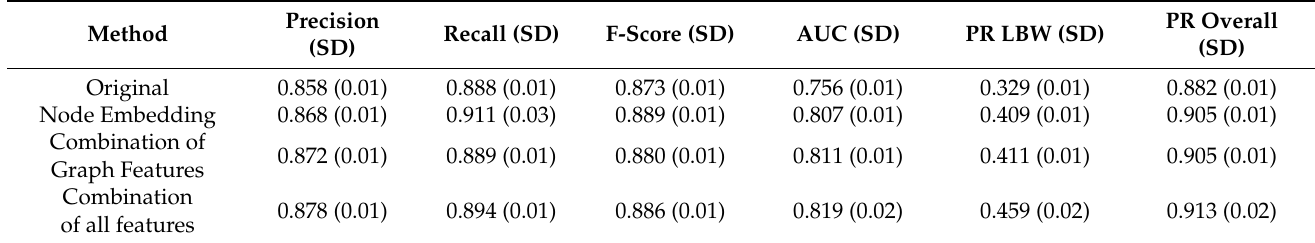
Table 8. Experimental results obtained using the LightGBM Classifier.